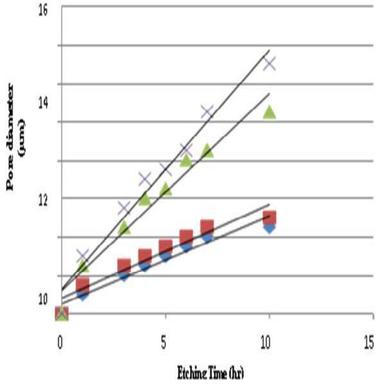
Variation of pore diameter with etching time for 132Xe (14.5 MeV/u) at various temperatures of etching solution in Makrofol-KG.